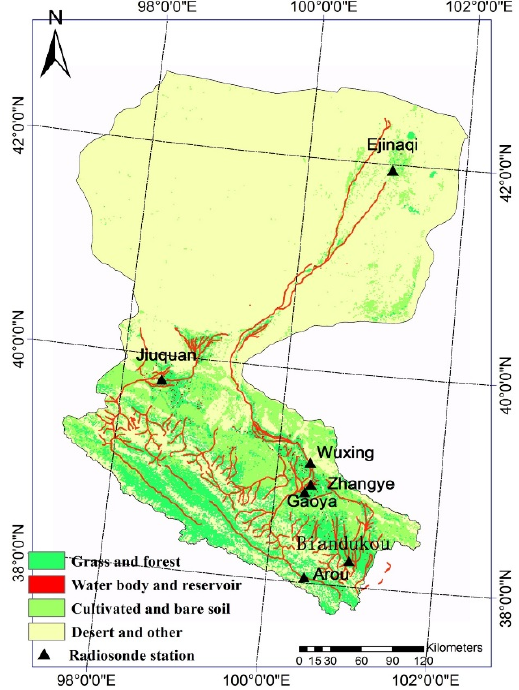
Figure 1. Heihe river basin location and landuse; location of radiosonde